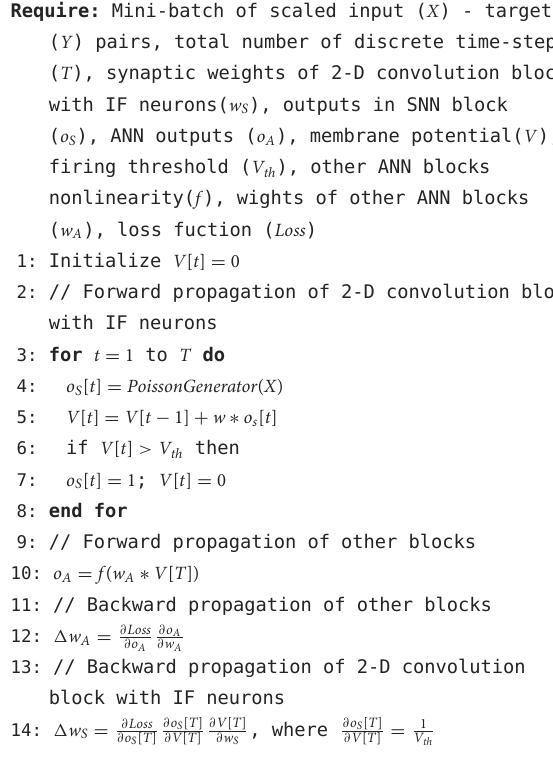
Algorithm 1. Forward and backward propagation of Spike-EEGNet for an